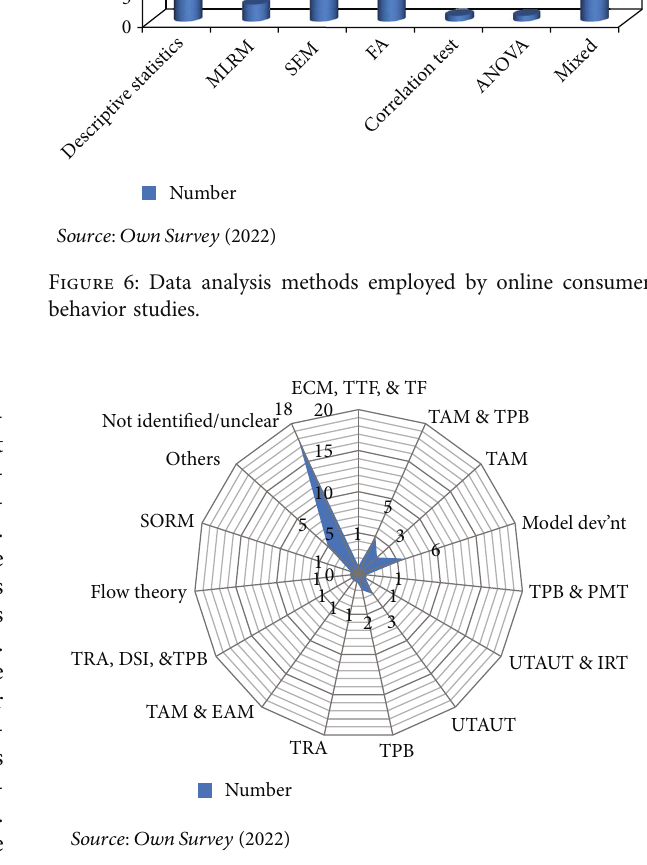
Figure 7: Model/theory employed by online consumer behavior